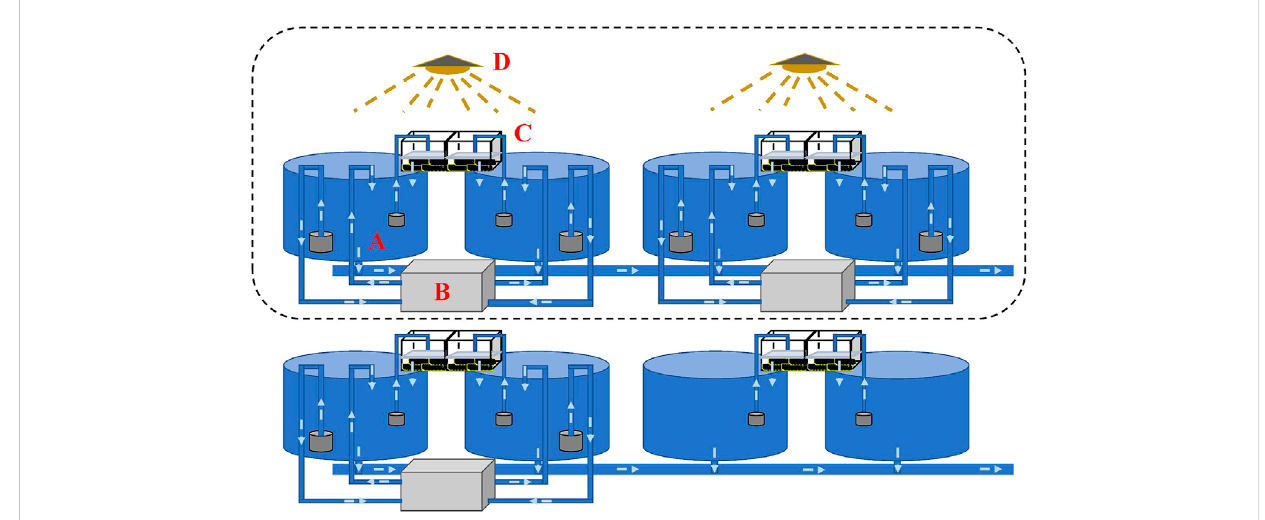
FIGURE 2 Design of a controllable recirculating aquaculture system. Each recirculating system/tank consists of a culturing tank [ (A) diameter = 0.9 m], a refrigerating machine (B) , a fi ltration system (C) , and a timing light (D) . Water temperature and photoperiod can be manipulated using the refrigerating machine and the timing light, respectively. The water volume in each recirculating tank was 1,100